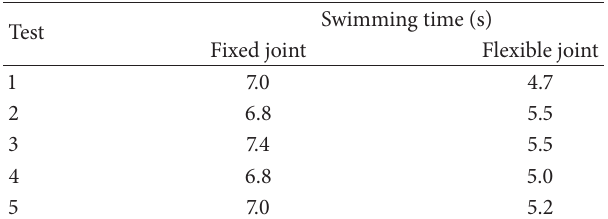
Figure 7: First prototype developed at the University of Canterbury, UC-Ika 1. Table 1: Time to swim 1.5 meter by the fish robot.